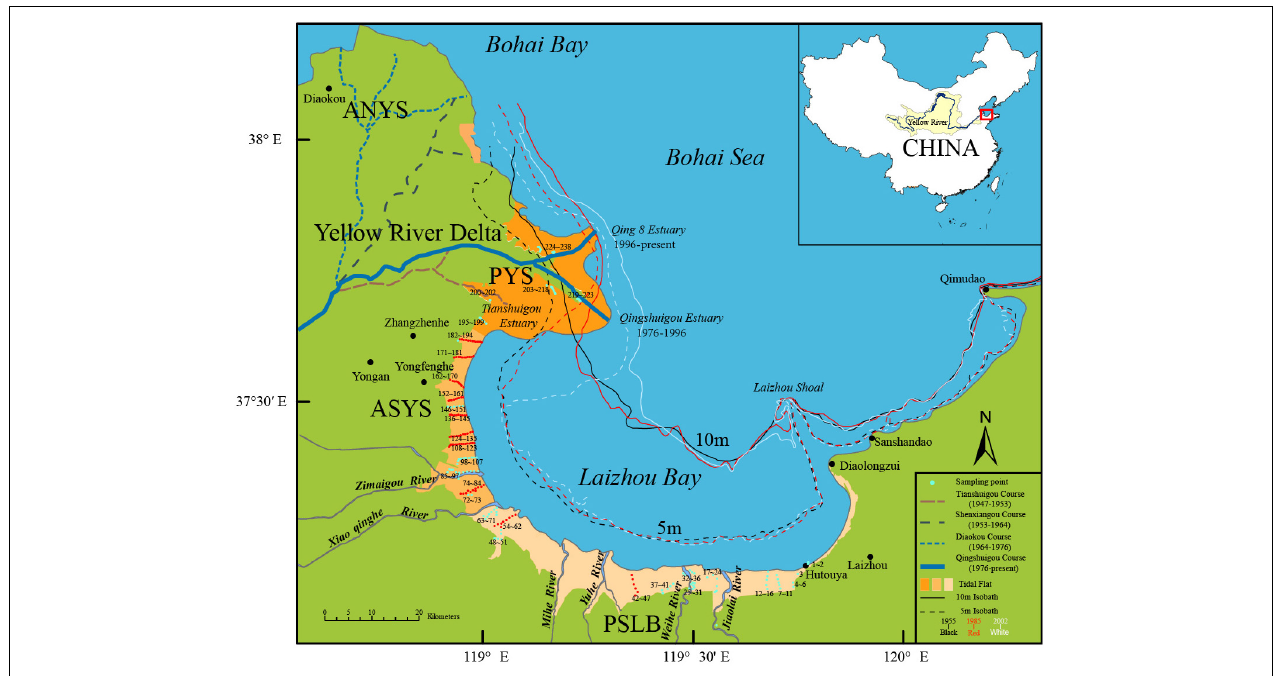
FIGURE 1 | Location of the abandoned southern Yellow River sub-delta (ASYS) and its adjacent zones (ANYS, PYS, and PSLB). Coastal topography evolution is drawn with the help of GIS based on nautical charts measured in 1955, 1985, and 2002. Sampling locations of tidal flat surficial sediment samples are arranged clockwise one after another from land to sea. The sample points making up 10 tidal flat transverse profiles are shown by red solid